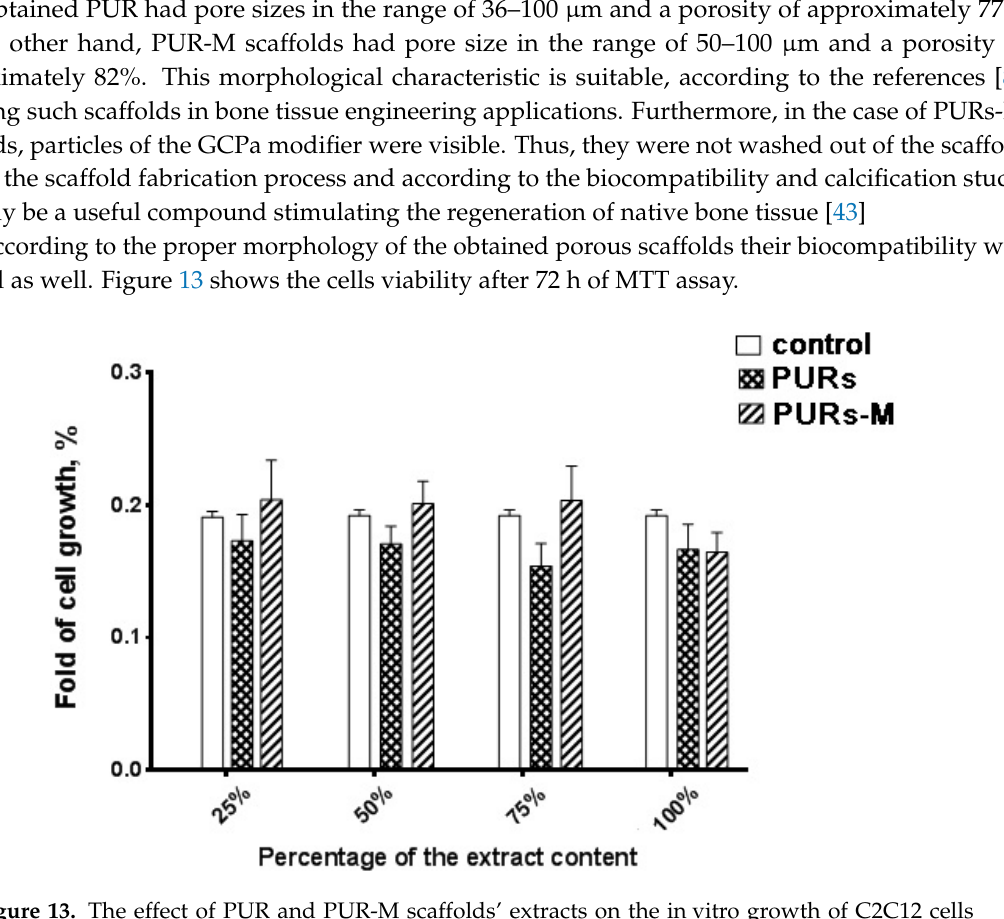
Figure 12. The PUR ( a ) and PUR-M ( b ) scaffold fabricated by SC/PL in combination with TIPS.